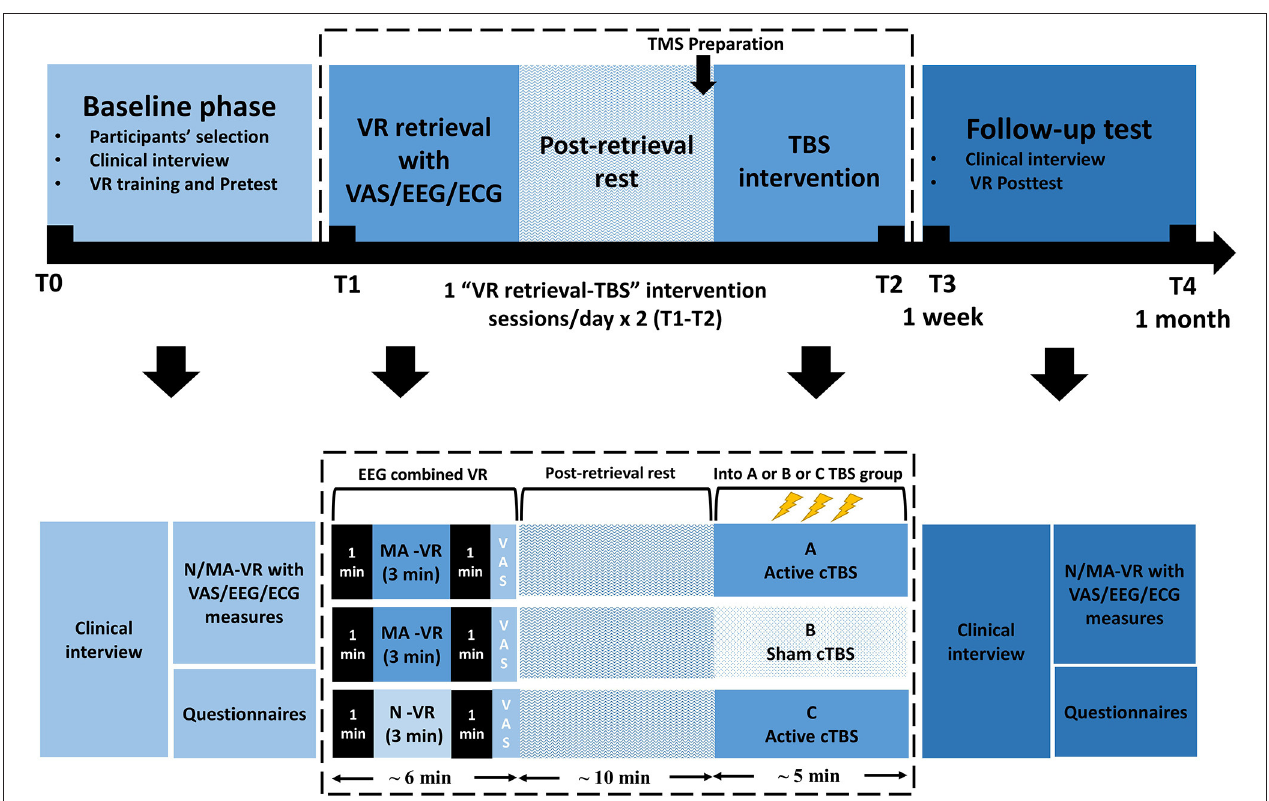
FIGURE 2 | Participants’ timeline. VR, Virtual Reality; cTBS, continuous theta-burst stimulation; N/MA-VR, neutral/methamphetamine scenes displayed by VR; VAS, visual analog scale; EEG, electroencephalography; ECG,